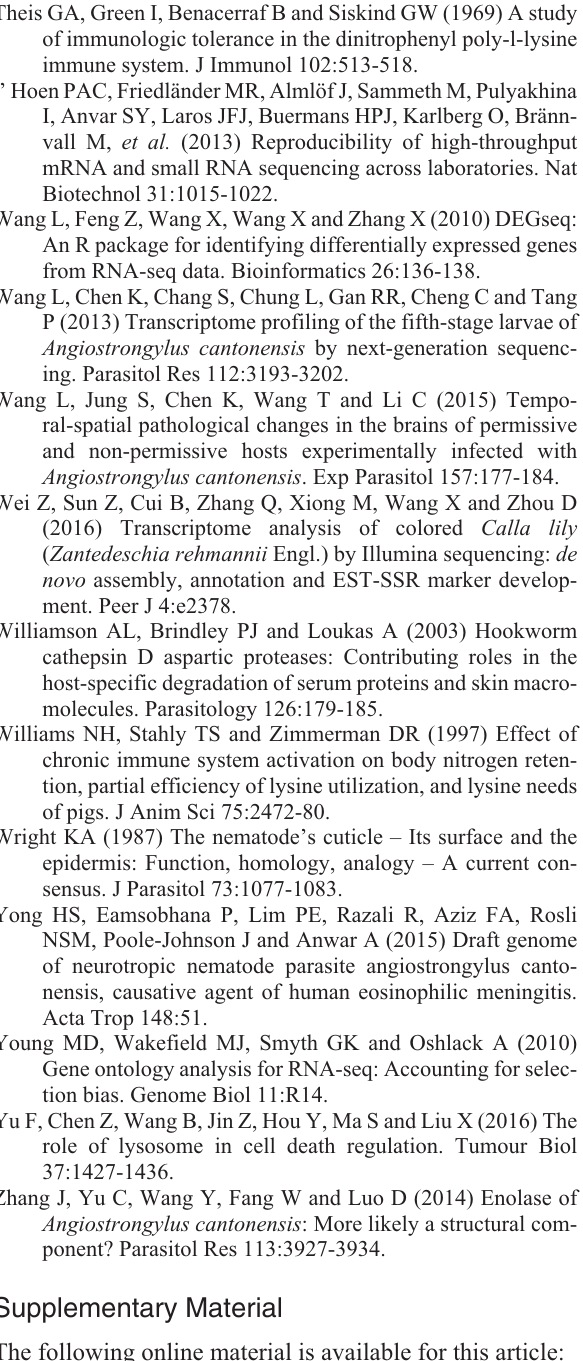
Table S1 - Primers for qPCR used in this study (designed with Primer 3.0). Table S2 - Summary of KEGG pathway annotation results for the P